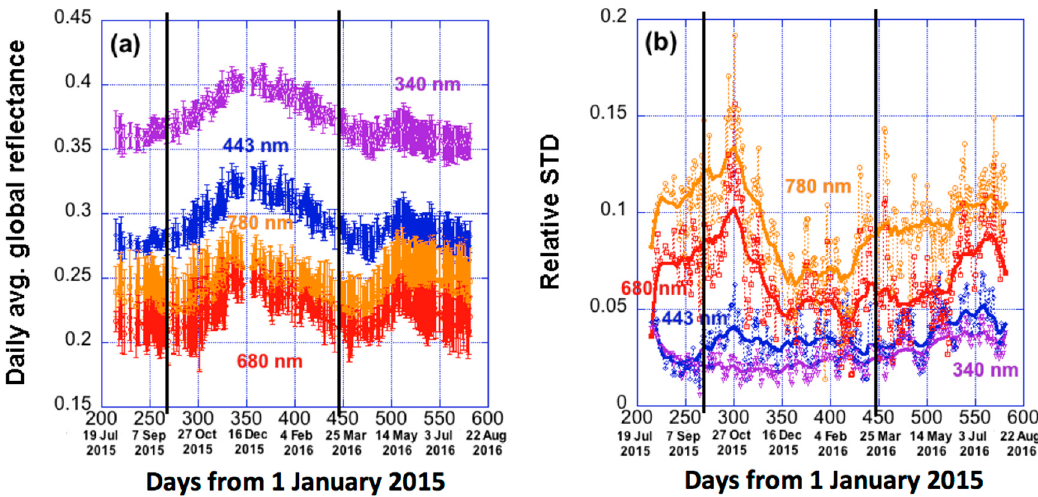
Figure 2. Time-series of daily average global reflectance at four wavelengths (340, 443, 680 and 780 nm) and its variability during a one-year period from 6 August 2015 to 3 August 2016. ( a ) Daily average global reflectance, with error bars indicating the standard deviation (STD) of global reflectance values within each day. ( b ) Relative standard deviation of global reflectance within each day (relative to daily average global reflectance). The solid lines are the smoothed lines of the relative STD data. For the whole year, the relative STDs reach 5%, 6%, 15%, and 18% at the four wavelengths. The two vertical black lines represent the two equinox dates of 23 September 2015 and 20 March 2016.